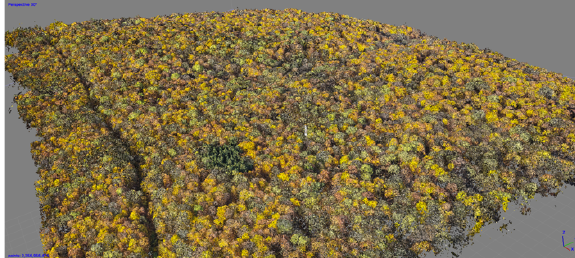
Figure 3: Perspective view of the dense point cloud model (full resolution point cloud with 2.23 billion points on approx. 100 ha) with attributed ortho mosaic RGB values. Hainich national park (partly showing the “Huss area”).